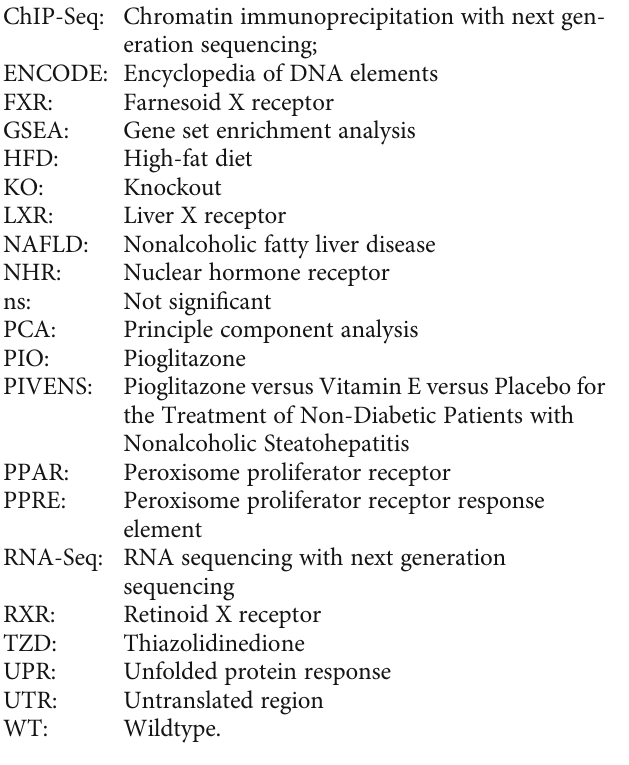
Table S1: gene-speci fi c oligonucleotide primers for RT- qPCR. Supplementary Table S2: RNA-Seq, ChIP-Seq, and BETA Analyses Results — see excel Table S2. This excel spreadsheet contains (A) List of Experimental Groups, (B) a merged summary of all RNA-Seq di ff erential expression